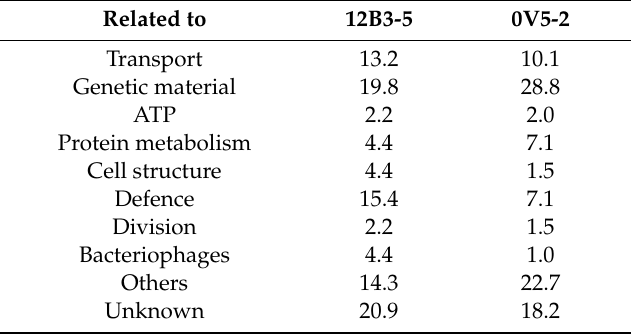
Table 3. Percentages of di ff erent types of non-shared proteins, present either in the 12B3-4 or the 0V5-2 proteomes, grouped according to their predicted